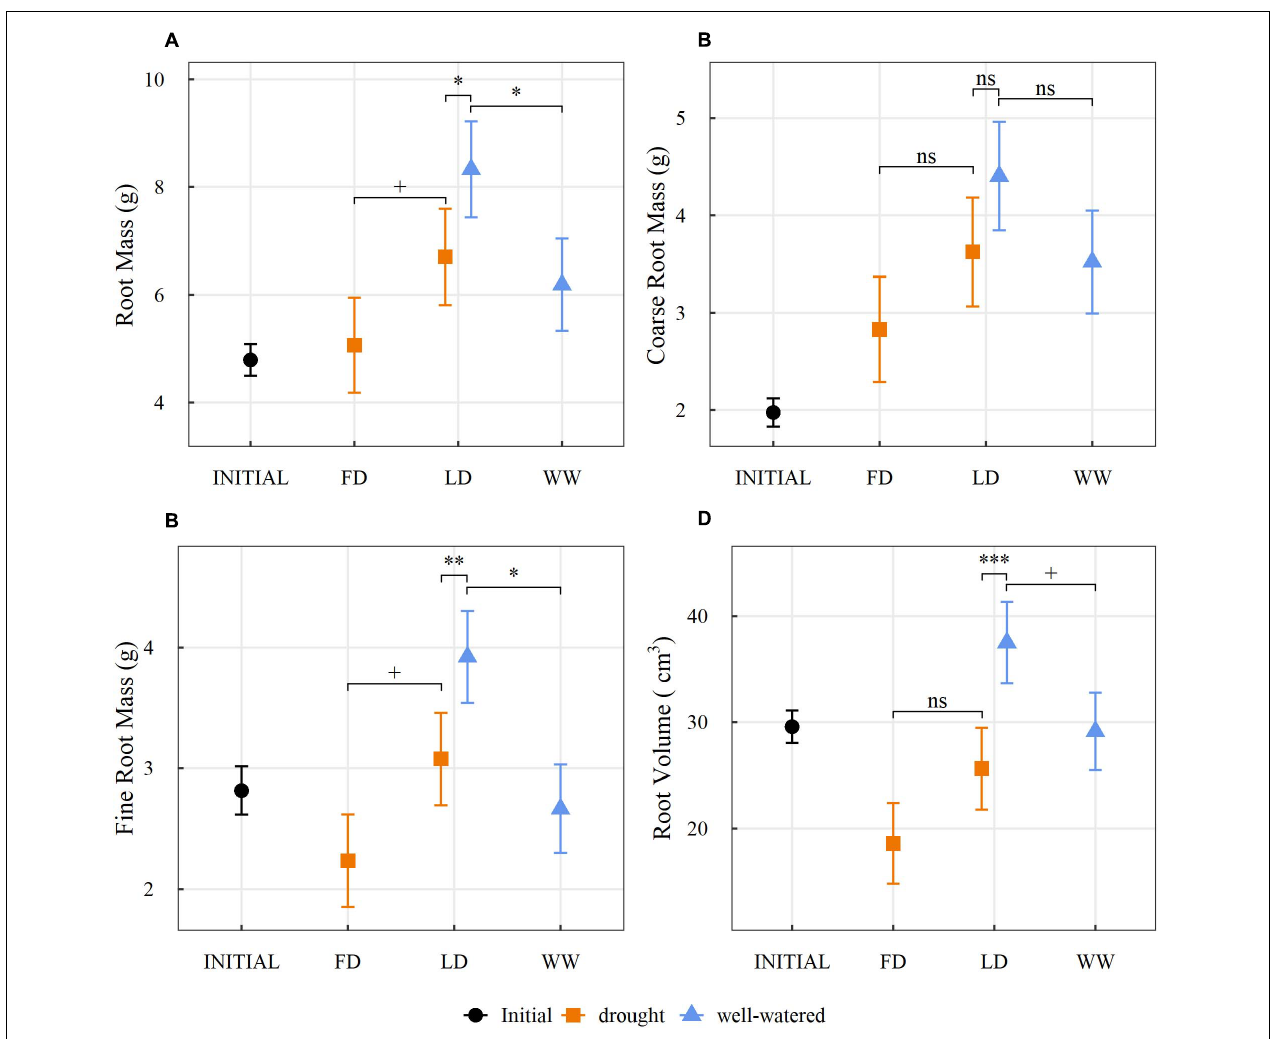
FIGURE 2 | Estimated marginal means ( ± 1 standard error) of (A) root mass (g), (B) coarse root mass (g), (C) fine root mass (g) and (D) root volume (cm 3 ) within the split root system of saplings, prior to (INITIAL) and after the three watering treatments (FD, full drought ; LD, localized drought ; WW, well-watered) (orange: dry, blue: well-watered). Statistical differences between the three planned comparisons (FD vs. LD-dry, LD-dry vs. LD-wet, WW vs LD-wet) are indicated by + for p < 0.1, * for p < 0.05, ** for p < 0.01, *** for p < 0.001 and ns for no significance ( n = 29; α =